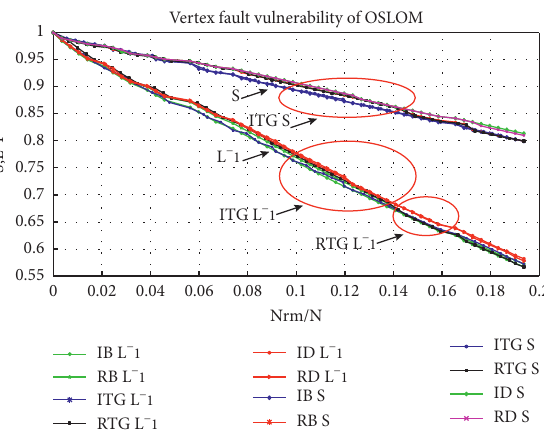
Figure 8: C G �( V,E ) result of LFR.